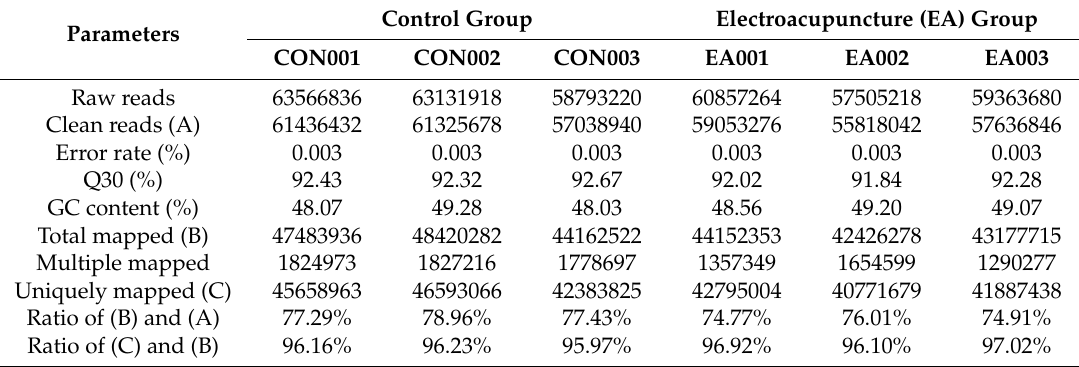
Table 1. The summary of the RNA sequencing analysis data.